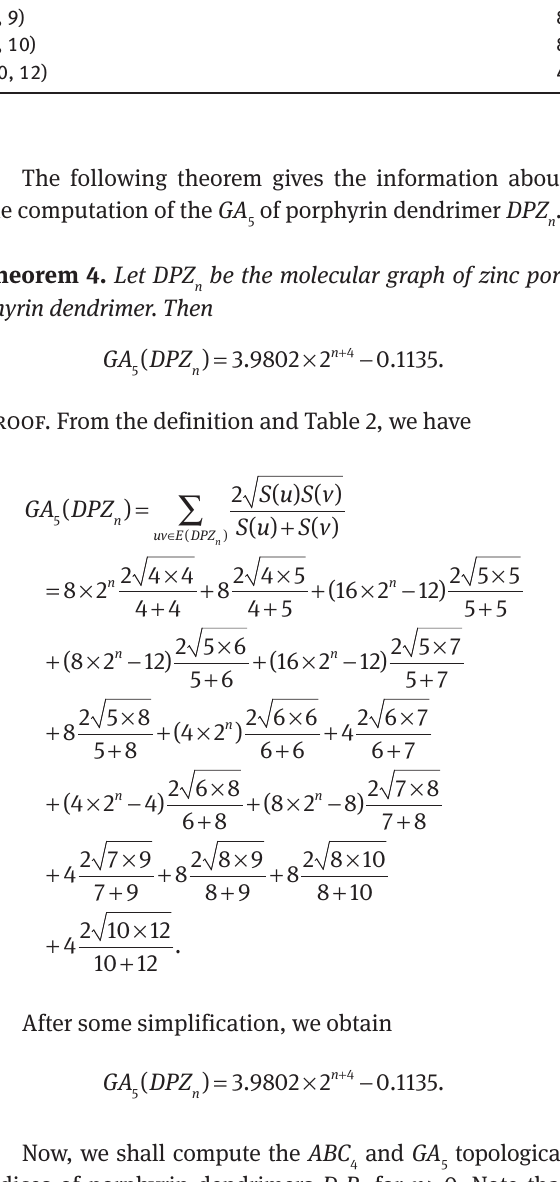
Table 2: Edge set partition of zinc porphyrin dendrimer DPZ on sum of degrees of vertices adjacent to end-vertices of every